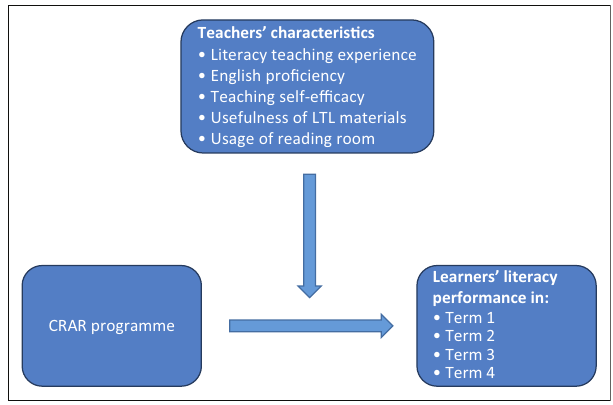
FIGURE 2: Design for evaluation question